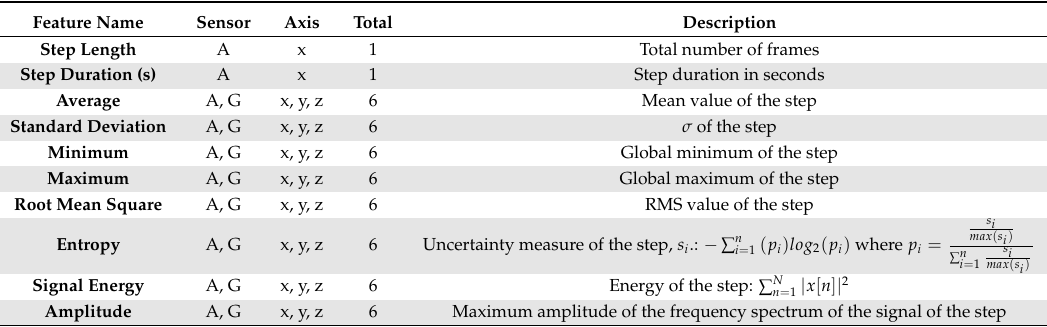
Table 4. Description of the extracted features for each step from the accelerometer (A) and/or the gyroscope (G). For each step, 50 features from the time and frequency domains are